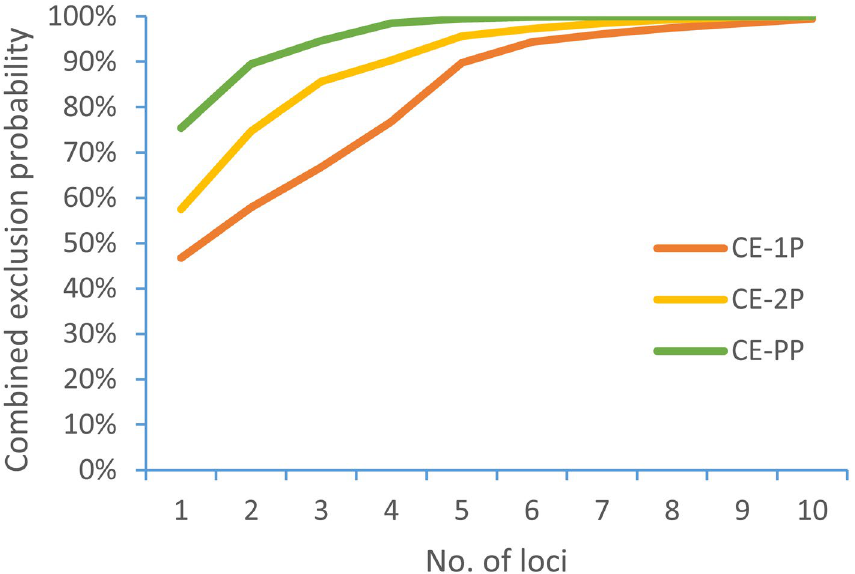
Figure 2. Combined exclusion probabilities based on the genotype of pair parent known (CE-PP), one parent known (CE-2P), and no parent known (CE-1P) of 10 microsatellites in a full-sib families of sterlet. Note: CE-1P: Combined exclusion probability (no parent known); CE-2P: Combined exclusion probability (one parent known); CE-PP: Combined exclusion probability (pair